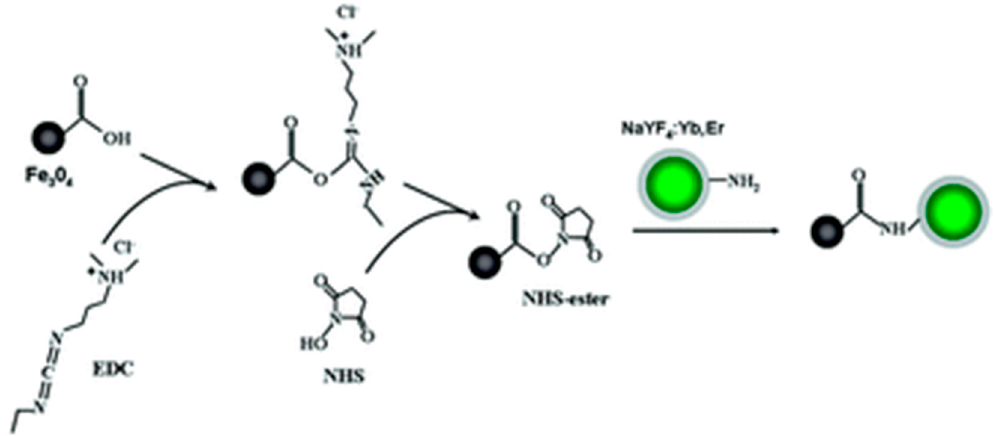
Figure 4. Schematic illustration of the formation of Fe 3 O 4 /NaYF 4 nanocomposites through EDC/NHS coupling chemistry. Adapted from ref. [41].